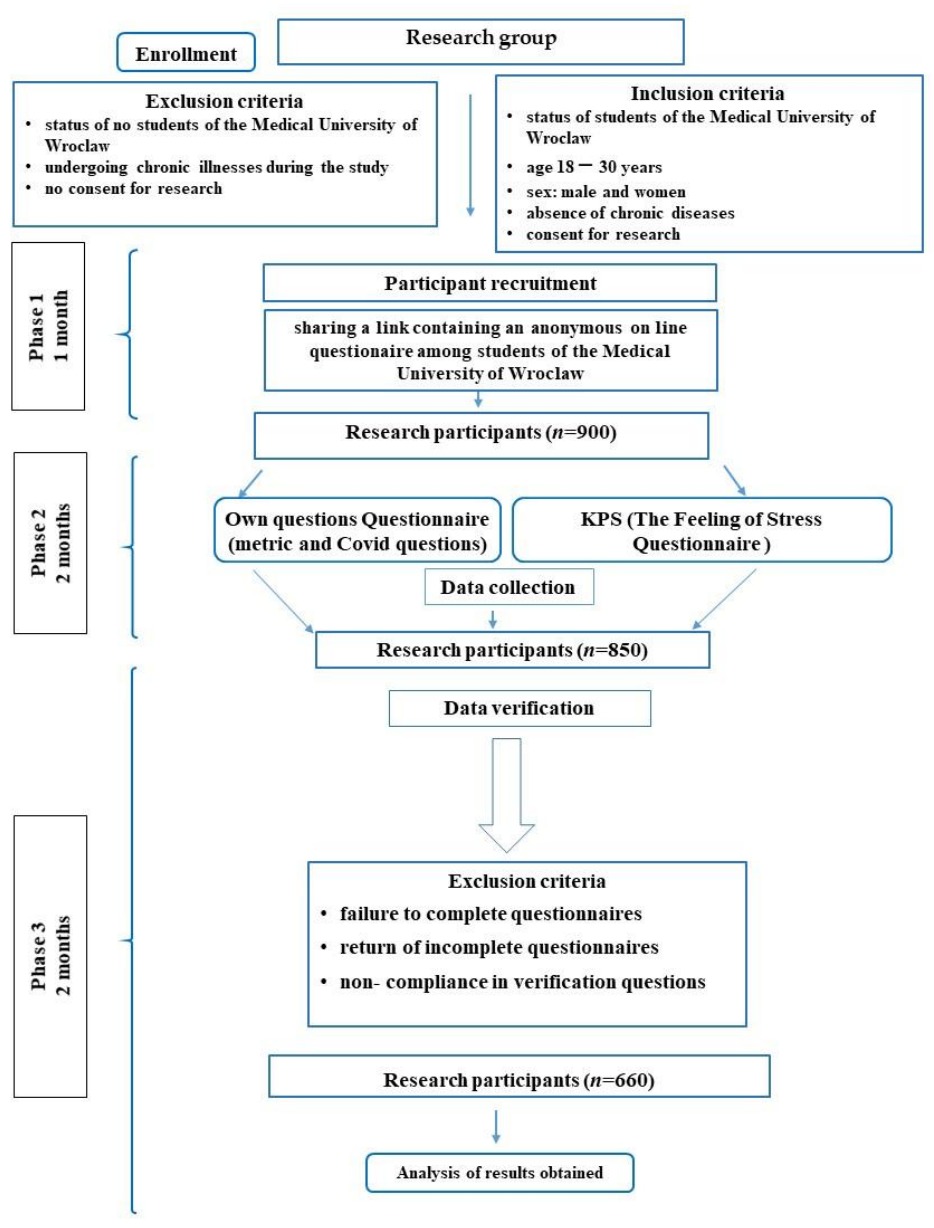
Figure 1. Selection process of the study.